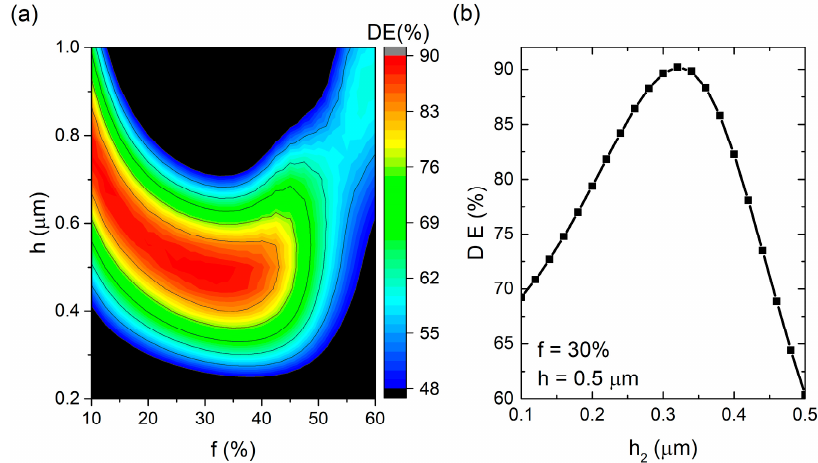
Figure 4. ( a ) Calculated GaP diffraction efficiency (DE) as a function of groove depth h and filling factor f , with h 2 =300 nm thick n AR ARC and ( b ) diffraction efficiency (DE) versus ARC thickness ( h 2 ) , at λ p = 2.06 µ m, d = 1.7 µ m, and 3 THz phase-matching frequency.